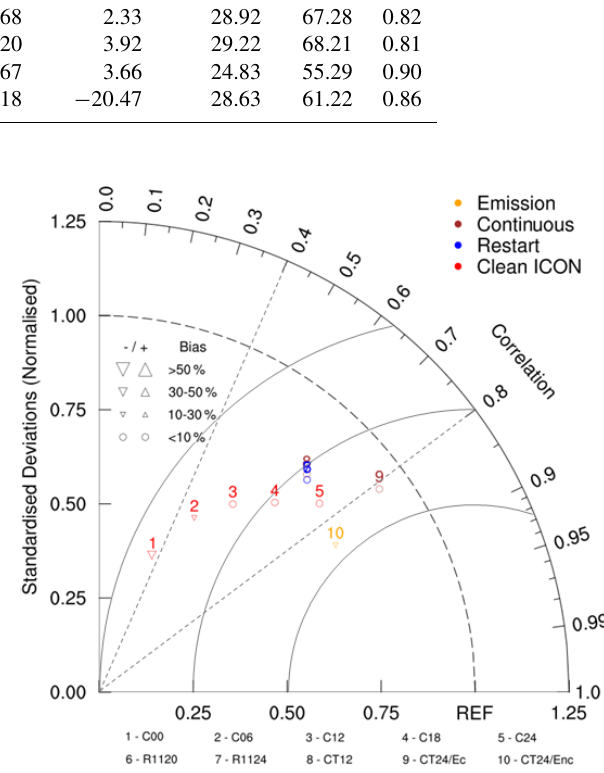
Figure 13. Taylor nomogram for modelled and observed daily PM 2 . 5 concentrations for all sensitivity experiments using differ- ent initial conditions and emissions. The red symbols indicate the clean initial simulations, the blue symbols represent the restart sim- ulations, the brown symbols show the continuous simulation sensi- tivity experiment, and the orange symbols represent emission tests. The triangles and circles signify “Bias”. The triangle’s size repre- sents the bias value, and the direction of the triangle’s vertex repre- sents a positive or negative